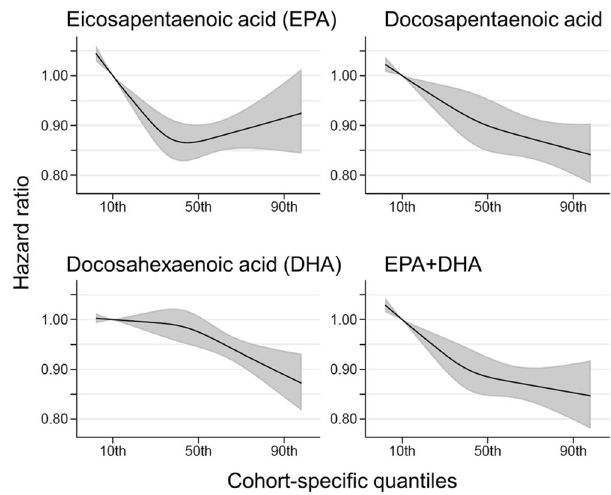
Fig. 2 Associations of circulating long-chain n-3 PUFA levels with all- cause mortality: nonlinear dose-response meta-analysis in the Fatty Acids and Outcomes Research Consortium. Hazard ratios and cohort- speci fi c quantiles are presented in the vertical and horizontal axis, respectively. The best estimates and their con fi dence intervals are presented as black lines and gray-shaded areas, respectively. The 10th percentile was selected as a reference level and the x -axis depicts 5th to 95th percentiles. Potential nonlinearity was identi fi ed for EPA ( p = 0.0004) but not for the others ( p > 0.05). All HRs are adjusted for age, sex, race, fi eld center, body-mass index, education, occupation, marital status, smoking, physical activity, alcohol intake, prevalent diabetes, hypertension, and dyslipidemia, self-reported general health, and the sum of circulating n- 6 PUFA (linoleic plus arachidonic